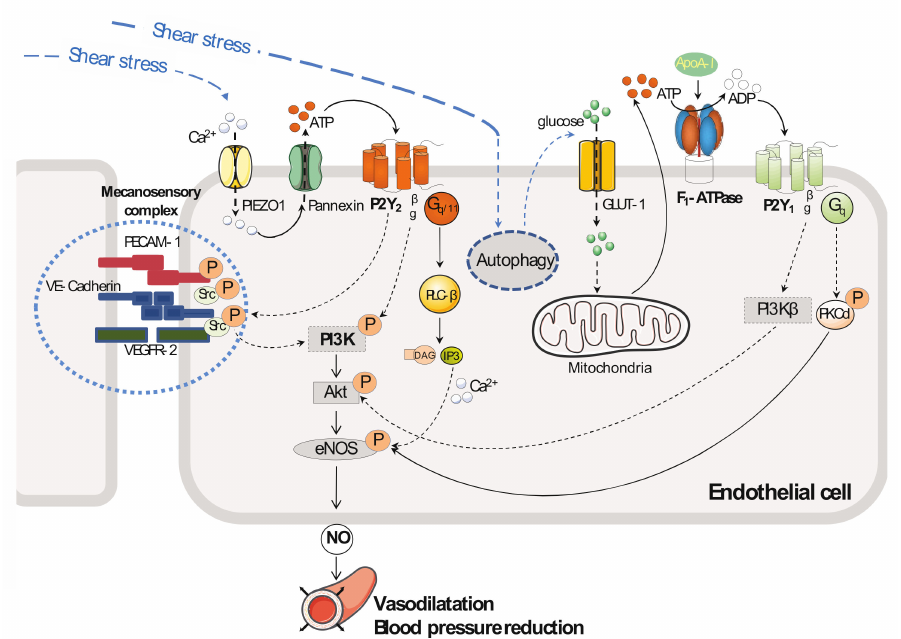
Figure 1. P2Y-R and vascular tone. P2Y 2 -R ( left ). Endothelial Piezo1 mediates flow-induced ATP release through pannexin channels. Extracellular ATP then activates a signaling pathway that involves the P2Y 2 -R/PLC β /PI3K/AKT signaling cascade, leading to phosphorylation/activation of endothelial nitric oxide synthase (eNOS). P2Y 1 -R ( right ). Shear stress increases autophagy, which sequentially promotes GLUT-1 expression, cellular glucose uptake, ATP production via the glycolytic pathway, and ATP release into the extracellular medium. Extracellular ATP can be hydrolyzed to ADP by ecto-F 1 -ATPase anchored to the plasma membrane of endothelial cells. This hydrolytic activity of ecto-F 1 -ATPase is stimulated by apoA-I, which is the main HDL apolipoprotein, and the newly generated extracellular ADP sequentially activates P2Y 1 -R, PKC δ or PI3K β /Akt, and eNOS. Both P2Y 1 -R- and P2Y 2 -R–mediated eNOS activation lead to the production of nitric oxide (NO), which diffuses extracellularly to promote blood vessel dilatation and a decrease in blood